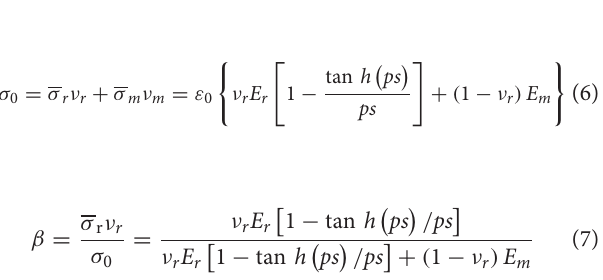
FIGURE 12 | Schematic of TiB strengthening mechanisms during creep rupture.